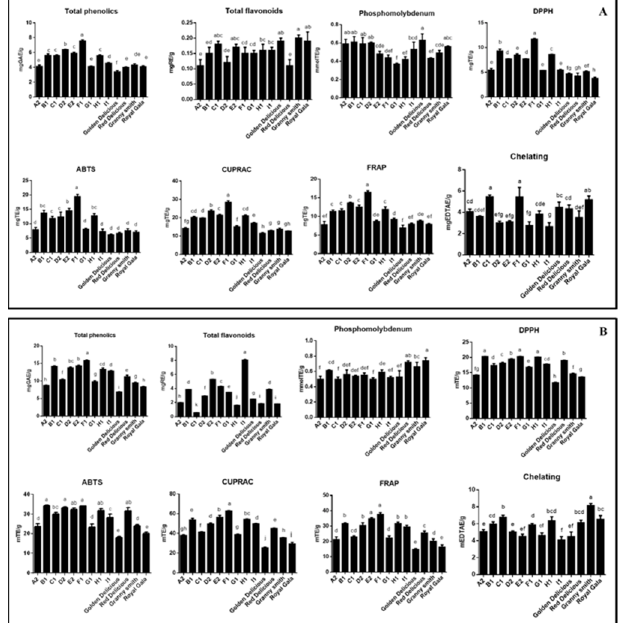
Figure 5. Total phenolic (TPC), total flavonoid (TFC) and antioxidant properties of tested Pulp extracts ( A ) and Peel extracts ( B ). Values expressed are means ± S.D. of three parallel measurements. GAE: Gallic acid equivalent; RE: Rutin equivalent; TE: Trolox equivalent; EDTAE: EDTA equivalent. Different letters indicated significant differences in each group (pulp or peels) ( p < 0.05).